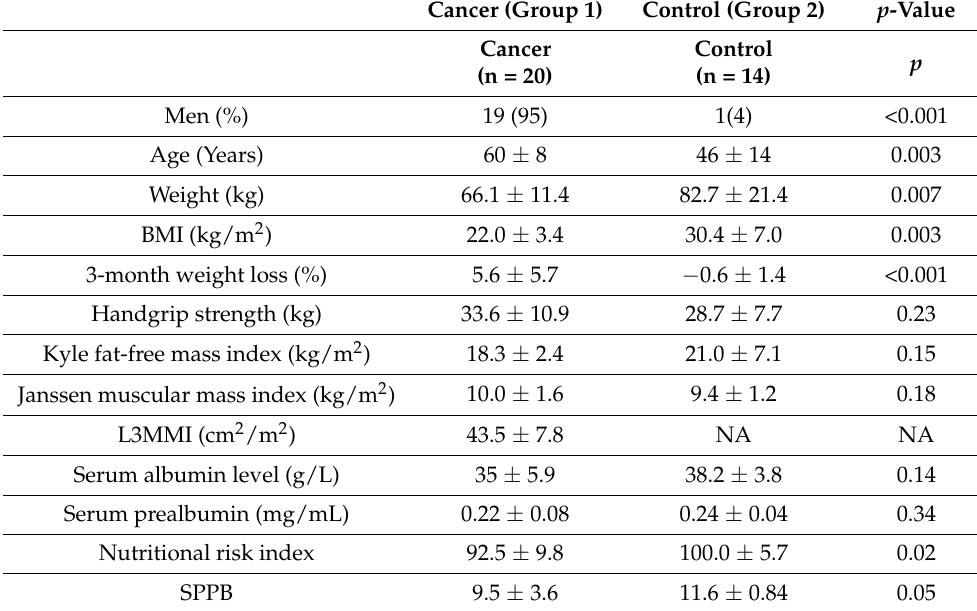
Table 1. Characteristics of the patients included in the